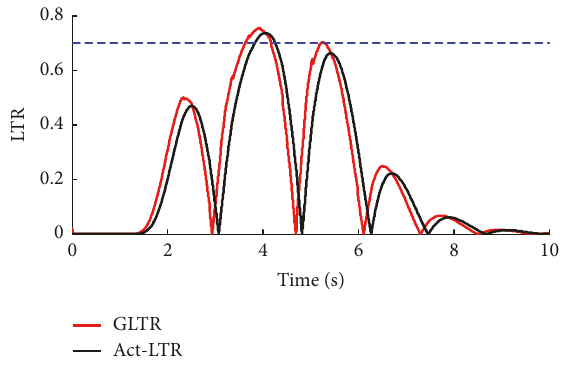
Figure 11: Prediction results for the 105-km/h DLC test.